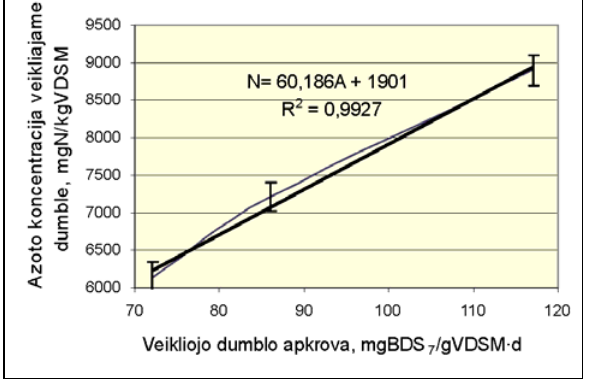
Fig 1. Dependency of nitrogen concentration in active sludge on active sludge load